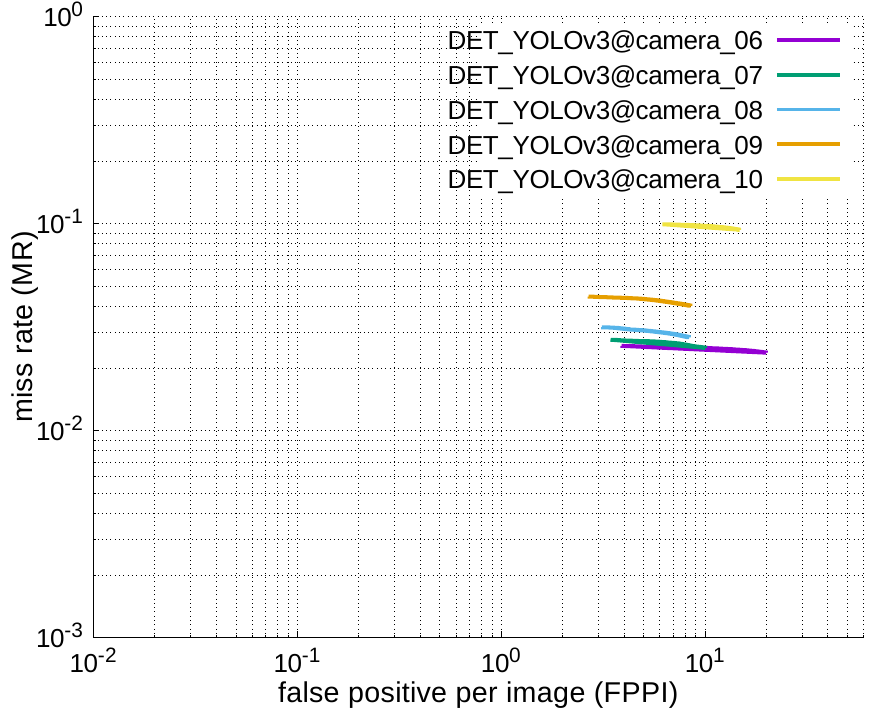
Figure 22. DET curves @ Cameras_06–10, YOLOv3.